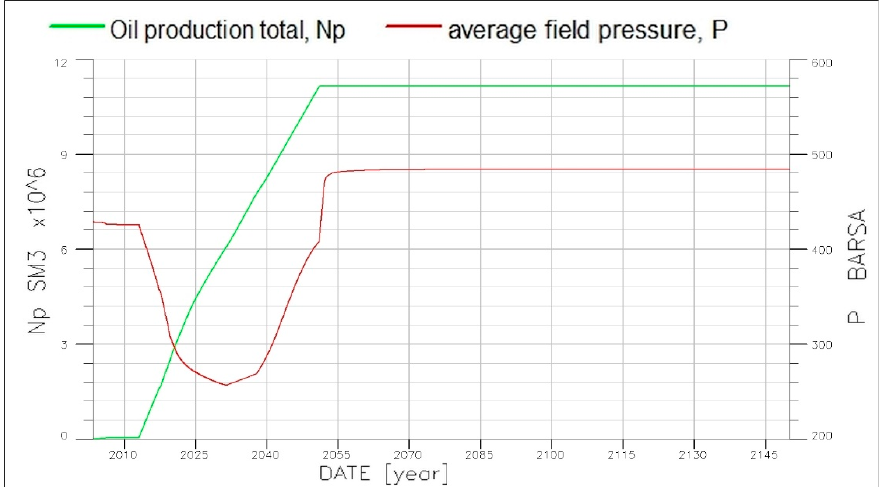
Figure 14. Basic scenario of oil production by enhanced oil recovery (EOR) with CO 2 injection. Total oil production, FOPT; and average reservoir pressure, FPR.